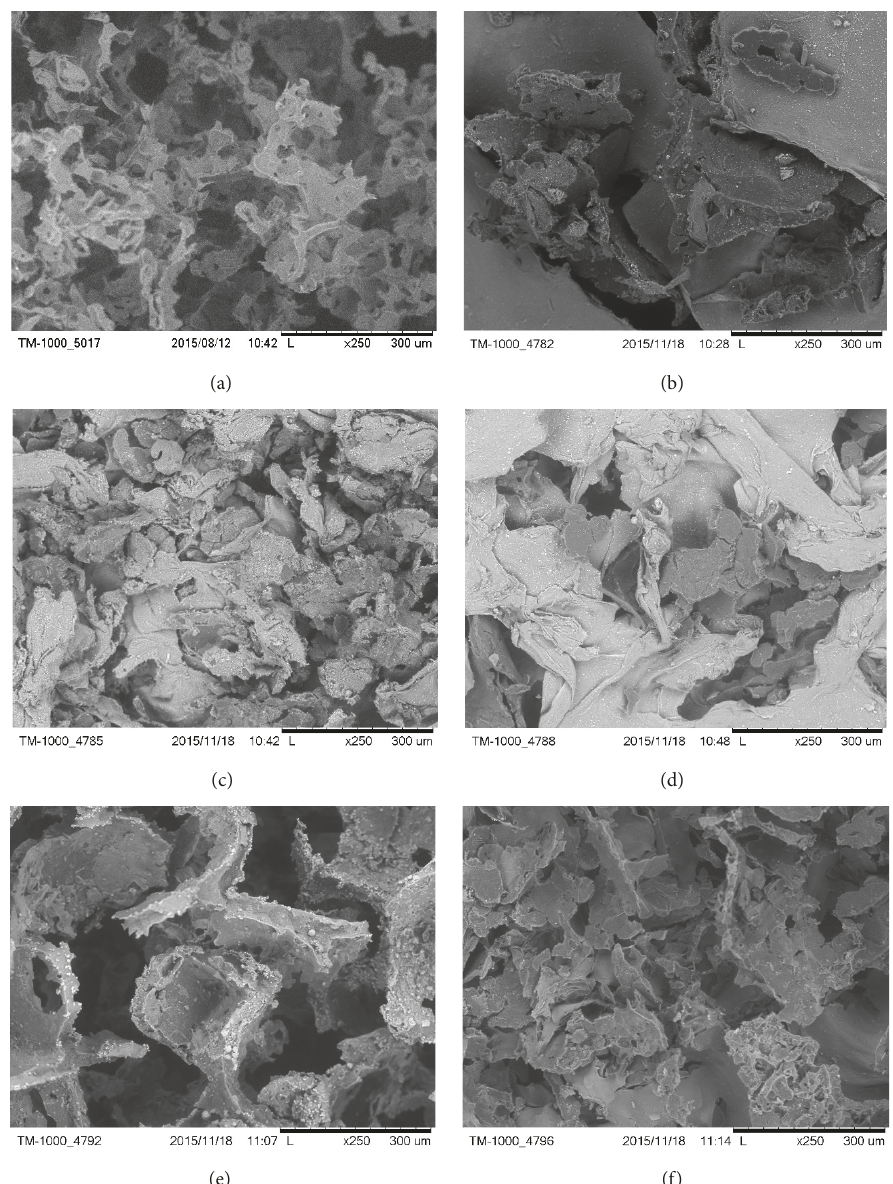
Figure 7: Surface morphology of porous 3D scaffolds infused with different carrageenan concentrations: (a) control (naked 3D scaffold); (b) 2% (w/v) carrageenan; (c) 4% (w/v) carrageenan; (d) 6% (w/v) carrageenan; (e) 8% (w/v) carrageenan; and (f) 10% (w/v)